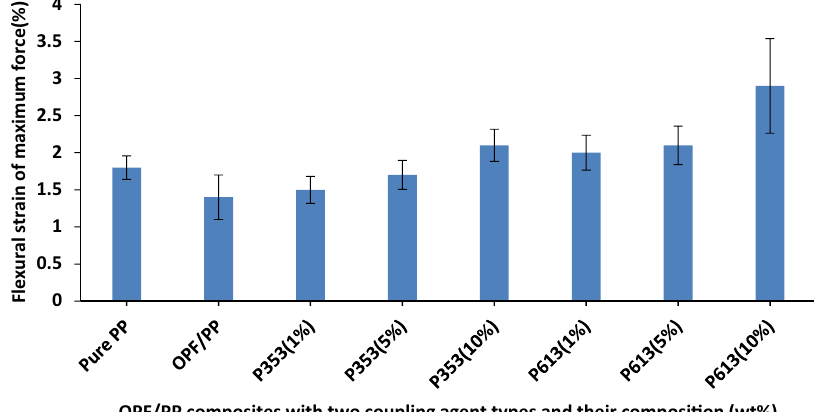
Figure 8: Flexural strain of the maximum force of the pure PP, uncoupled, and coupled 20% OPF/PP polymer composite with two coupling agent types of di ff erent weight percentages.